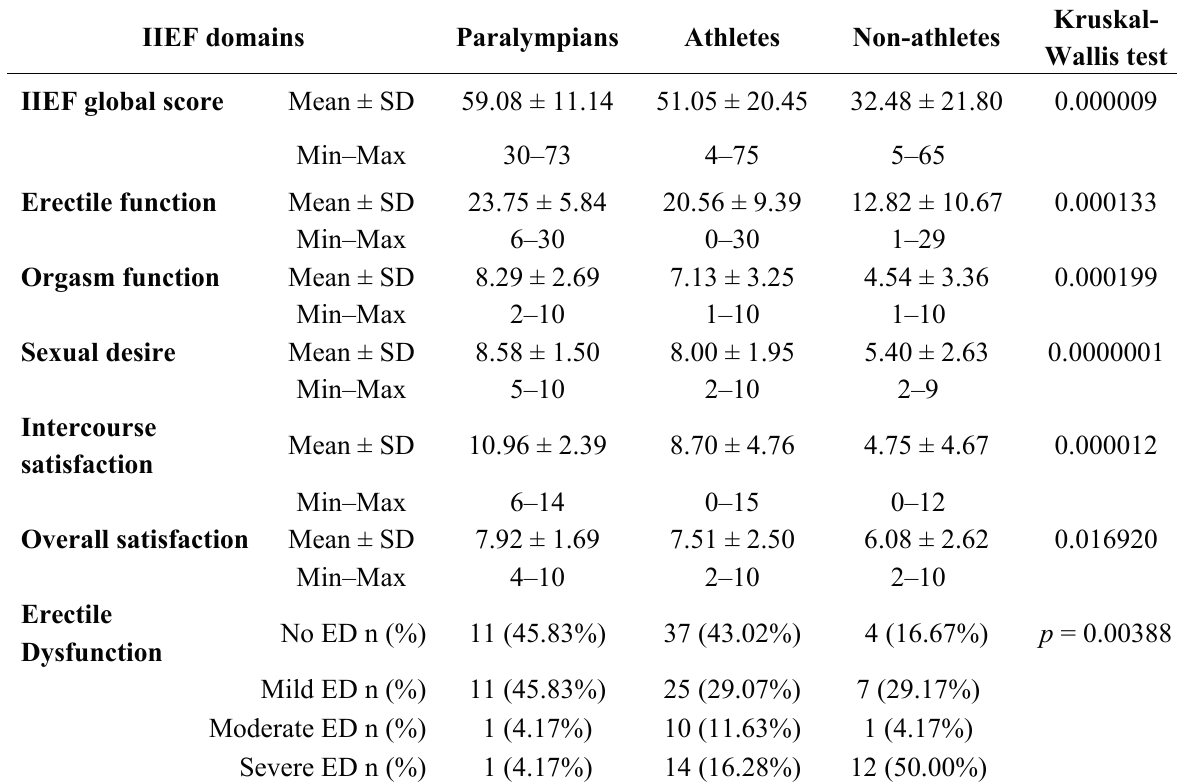
Table 3. IIEF scores in studied men (mean ± SD; min–max;